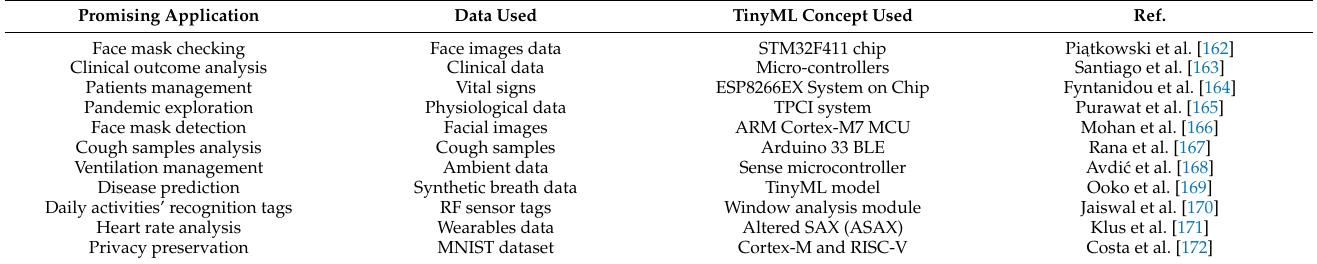
Table 5. Summary of promising applications of TinyML in the era of COVID-19. Promising